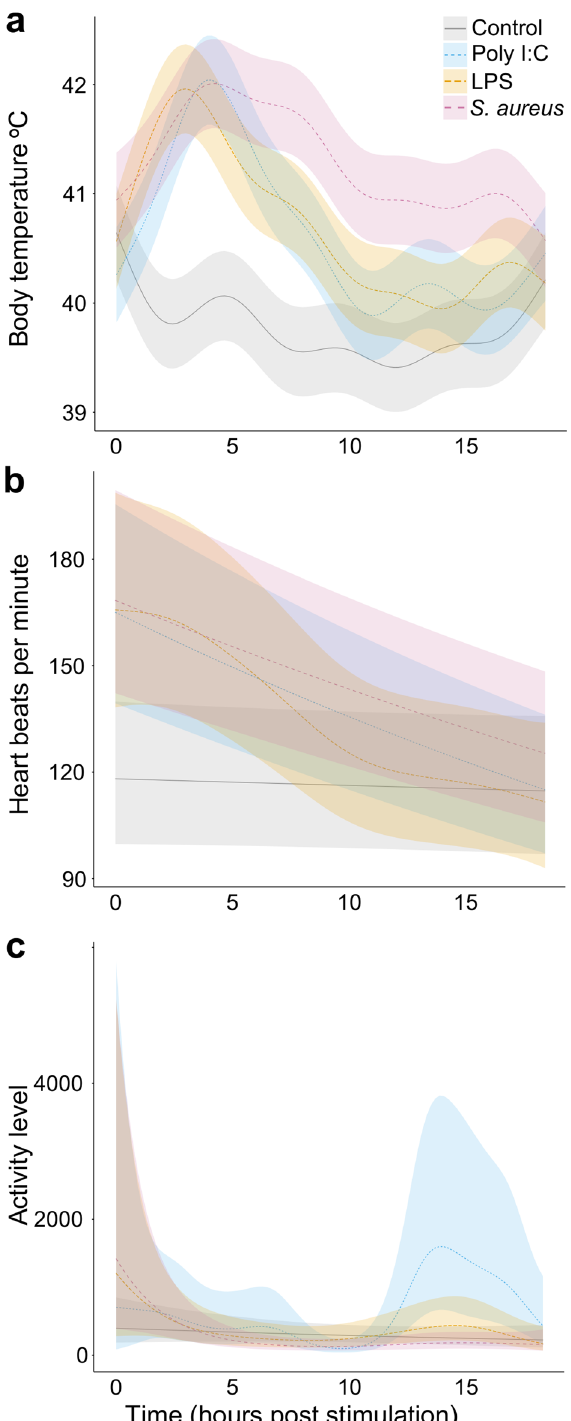
Figure 1. Physiological changes following challenge with immune stimulants. Changes in ( a ) body temperature, ( b ) heart rate and ( c ) activity level were measured remotely using bio-loggers. Mean and 95% credible interval for each treatment group was plotted until 18.5 h post stimulation, as estimated from the posterior distribution of the GAMM. An activity value of 0 means no activity, while higher values mean more movement in either or all of the three